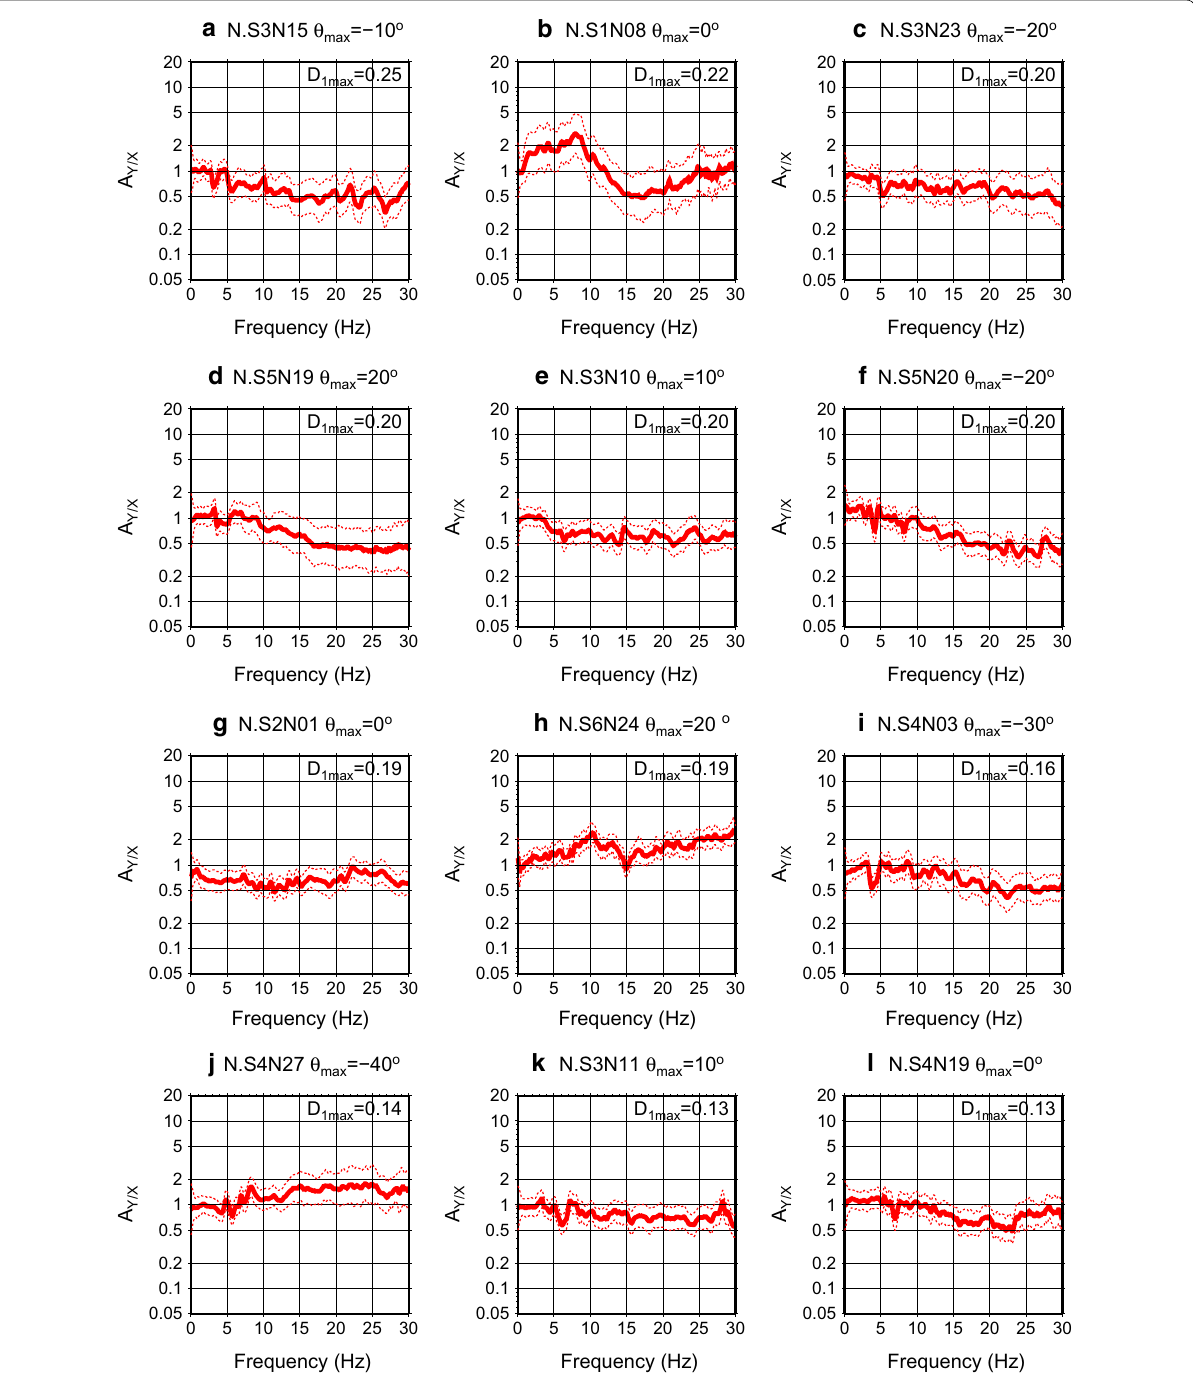
Fig. 8 Average Y/X amplitude spectral ratio (solid red curves) and logarithmic standard deviation (dotted red curves) at θ 12 S-net stations with the largest D 1max , amongst those installed at water depths shallower than 1500 m. The θ max and D 1max values for each station are written at the top and inside of each subfigure,